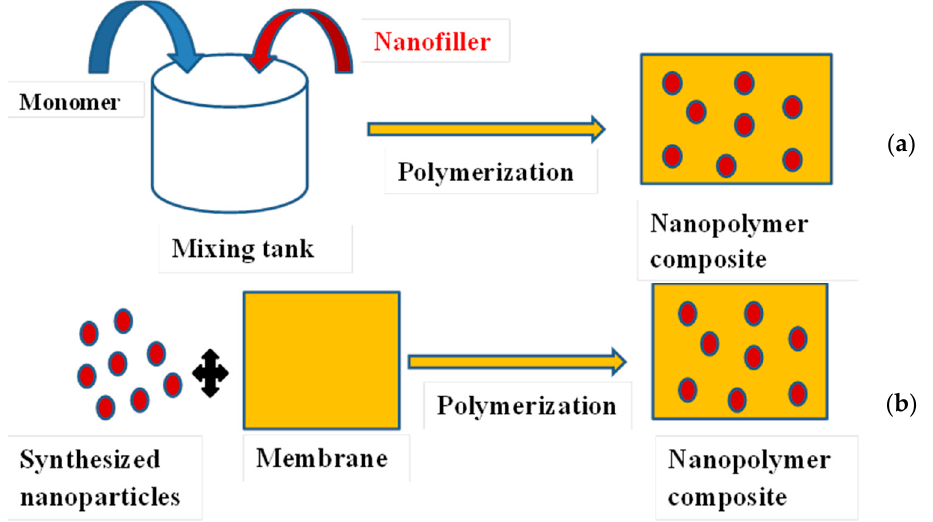
Figure 3. Schematic representation of in situ ( a ) and ex situ ( b ) polymerization.